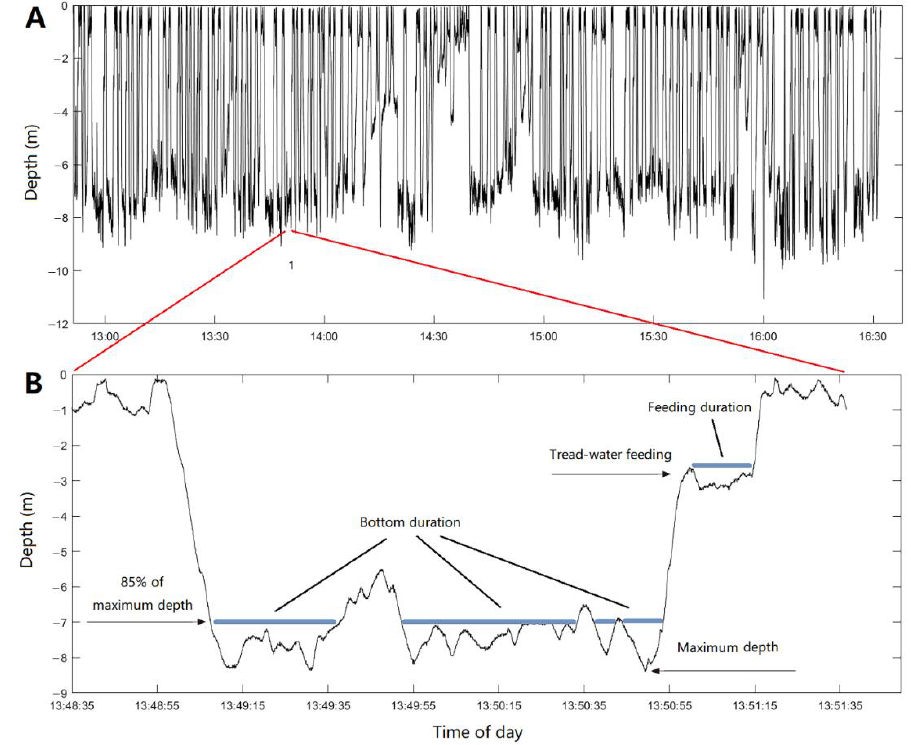
Figure 2. ( A ) The whale dive profiles of the total track duration on 2 July 2021. ( B ) An example of bottom duration and tread-water feeding in a dive. The bottom duration was the duration spent at the bottom deeper than 85% of maximum depth in each dive.